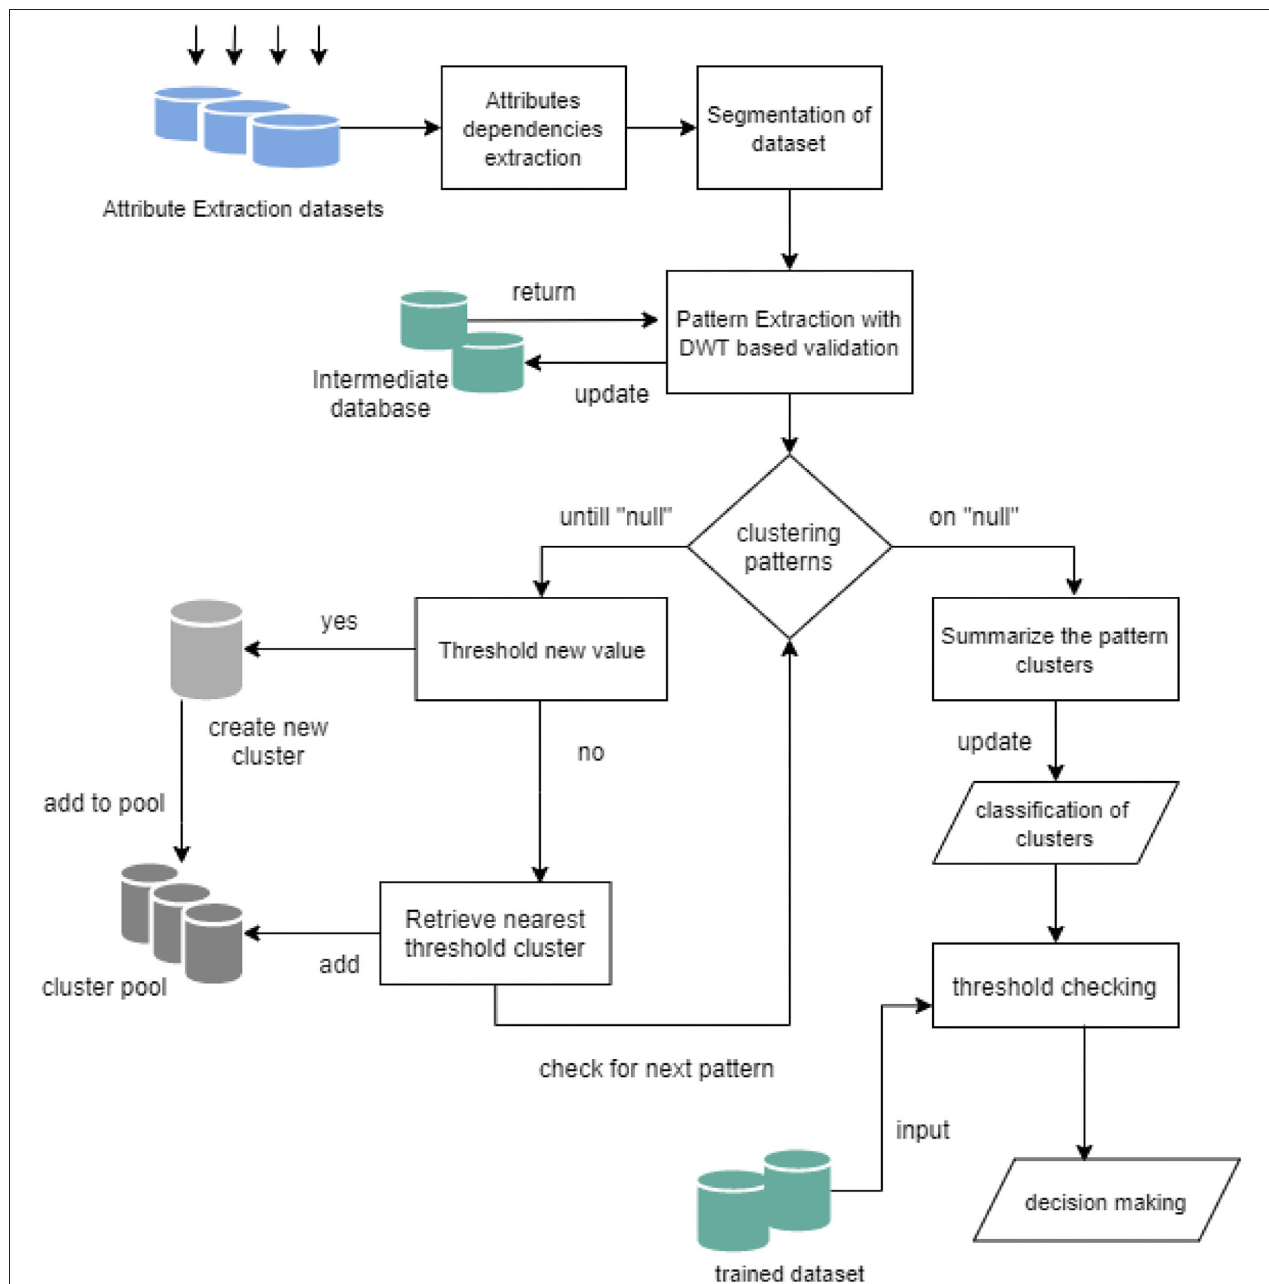
FIGURE 2 | Comparative model for validating speech signals in distress detection.